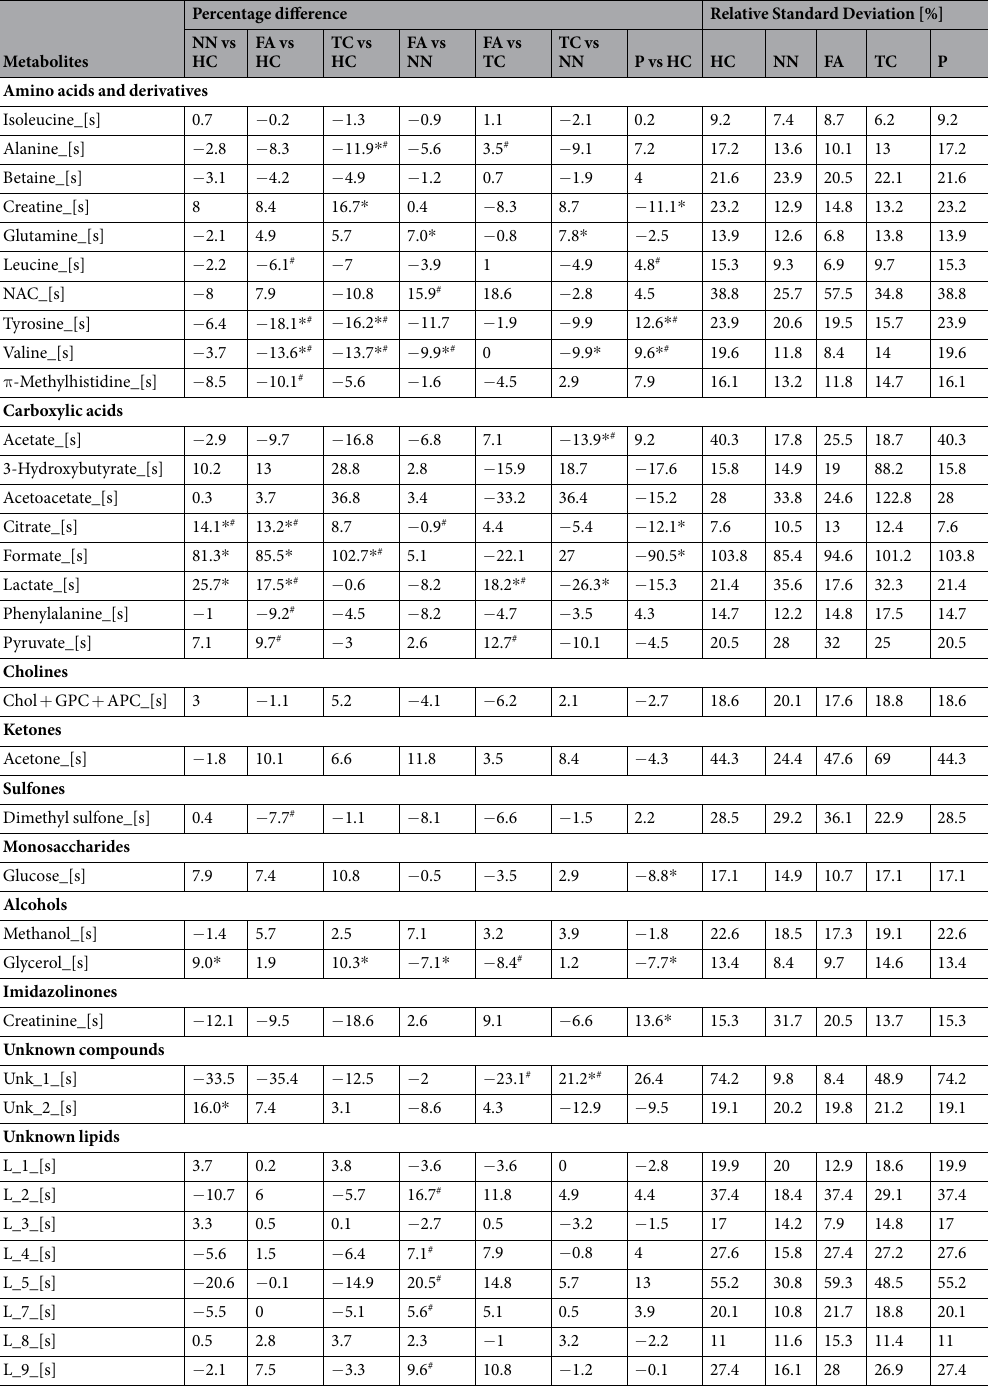
Table 3. Significantly changed serum metabolites ( # - VIP plot selected metabolites; * - statistically significant